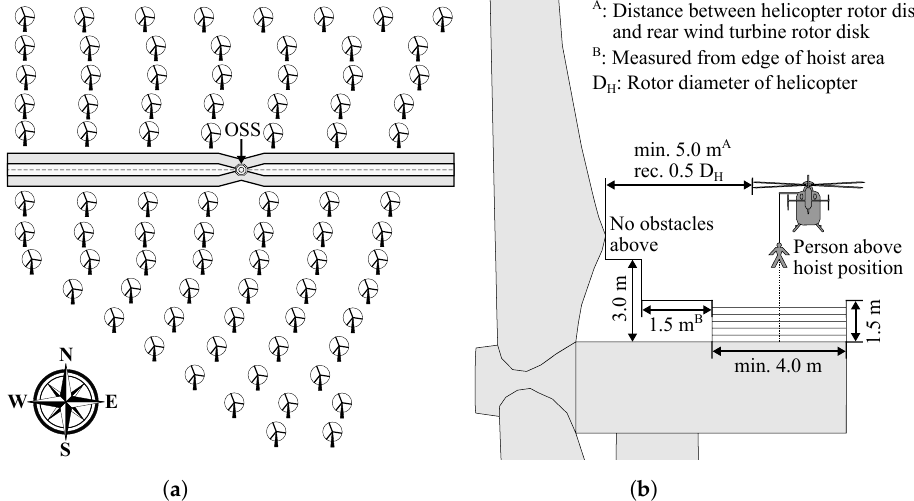
Figure 1. German regulations for maritime helicopter operations in offshore wind farms. ( a ) The inner and outer flight corridor at the offshore wind farm Global Tech I (GTI) [20]; ( b ) Lateral safety clearance for the helicopter hoist area at offshore wind turbines (WTs)